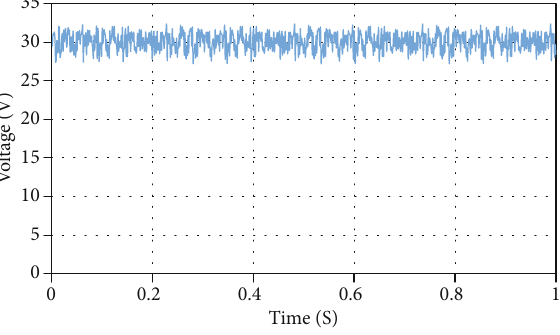
Figure 38: The output voltage of PV2.